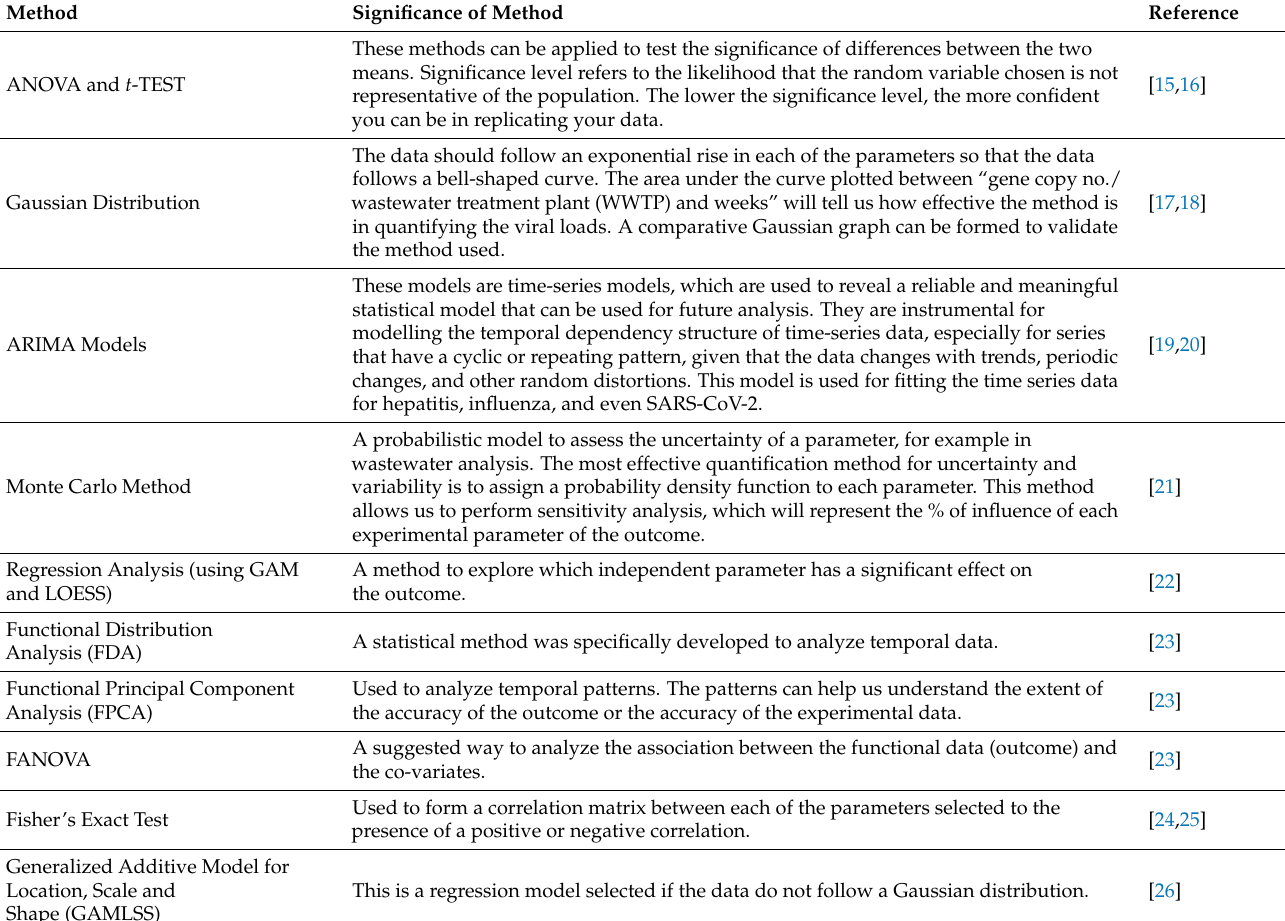
Table 1. Review of different statistical methods for wastewater-based epidemiology